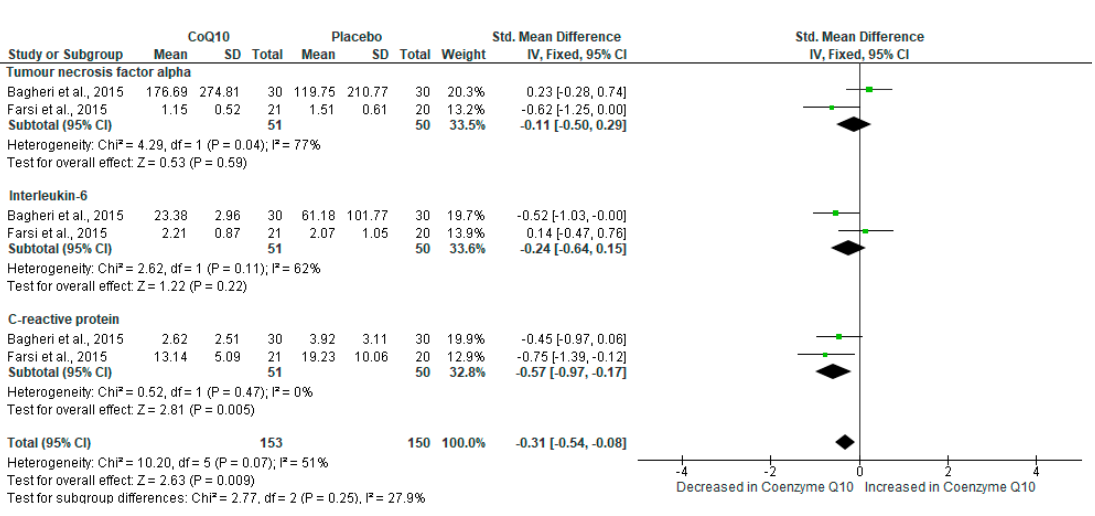
Figure 3. The impact of coenzyme Q 10 (CoQ 10 ) supplementation on markers of inflammation, such as tumor necrosis factor-alpha (TNF- α ), interleukin-6 (IL-6) and C-reactive protein (CRP) in individuals with metabolic syndrome.